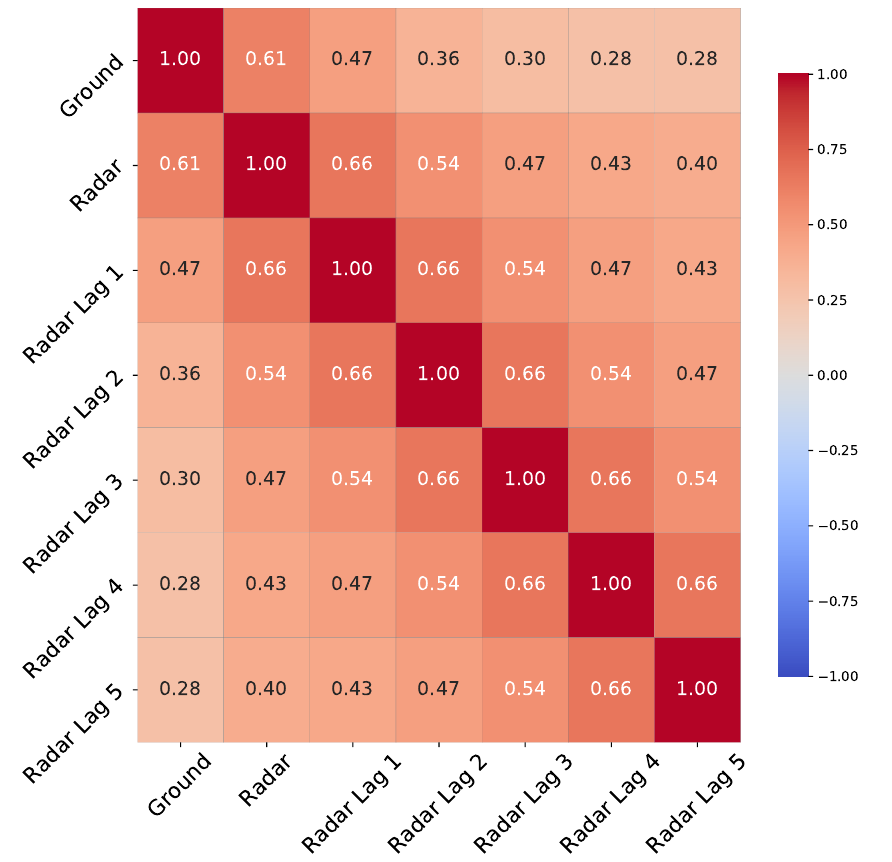
Figure 8. Correlation of radar based precipitation ( Z – R relationship) with different time lags and ground observations calculated for the complete data set with 10-min time resolution.